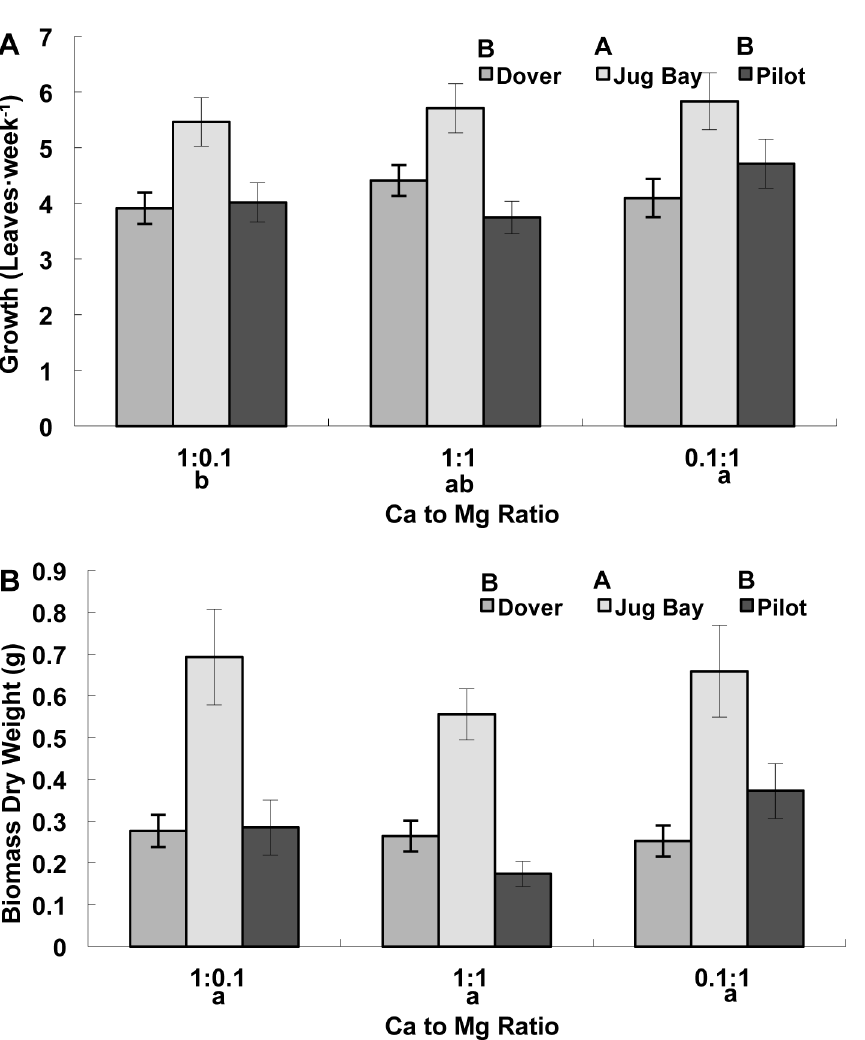
Figure 2. Rosette growth and biomass production of juvenile plants of three A.l. ssp. lyrata populations. A. Growth rate (leaves per week) and B. biomass (dry weight). All data are presented as a mean 6 standard error (n=16). The plants were from serpentine (Pilot), limestone sand (Dover), and sandy loam (Jug Bay) soils. Different upper case letters indicate significant differences among populations, and different lower case letters indicate significant differences among substrate Ca to Mg ratios as separated by Tukey’s HSD (P ,